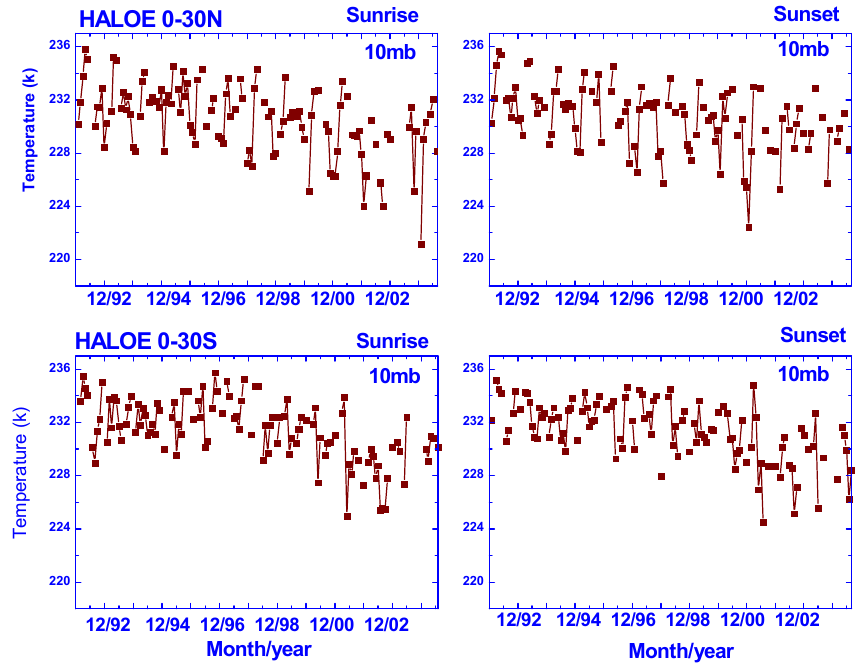
Fig. 1. Time series of zonal mean (0–30 ◦ N) and (0–30 ◦ S) sunrise and sunset HALOE temperature over the period January 1992–August 2004 at 10mb ( ∼